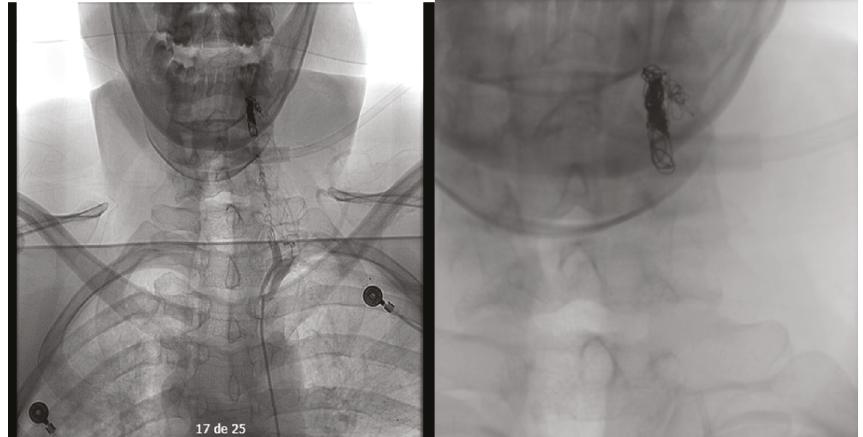
Figure 3: Panangiography depicting vertebral artery occlusion. The fistula is occluded with five Axium coils and a vial of Squid